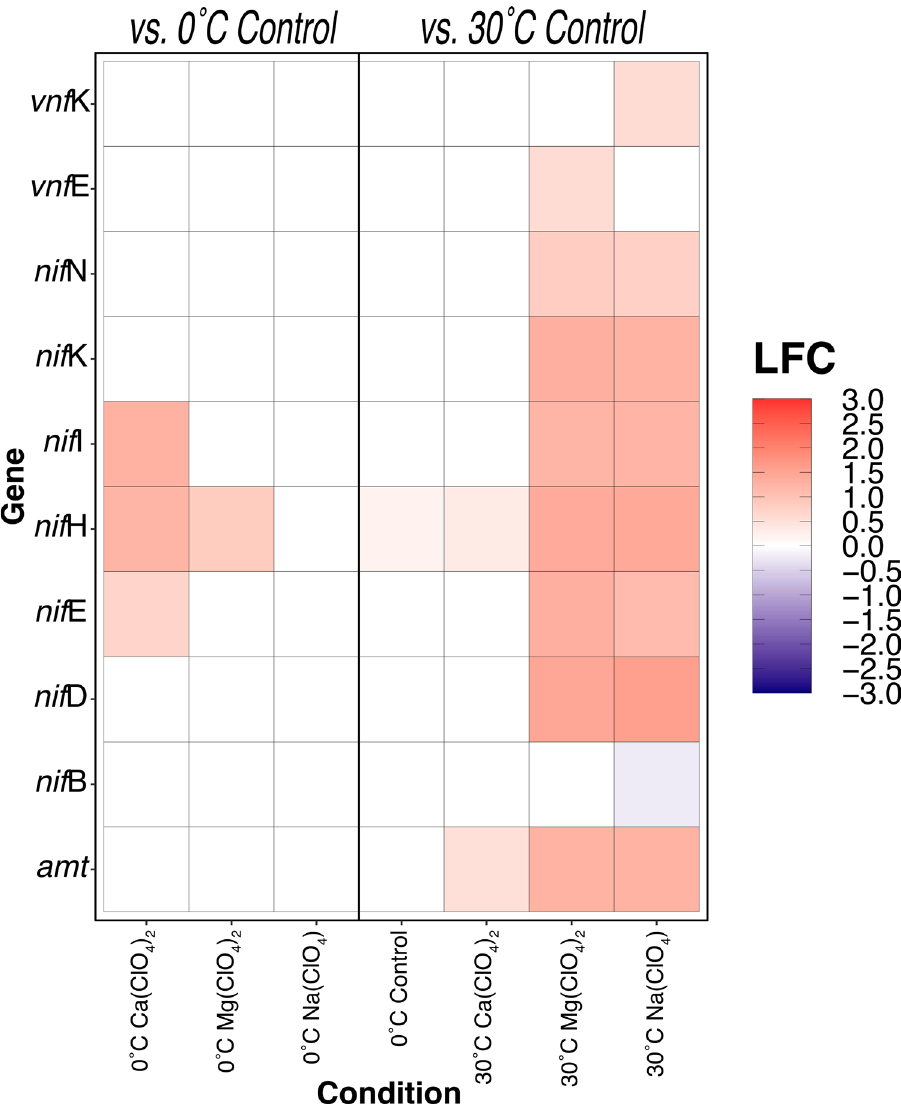
Figure 4. Differential expression (Log 2 -fold change, LFC) of ammonium transporters ( amt ), Mo-containing nitrogenase ( nif ), and V-containing nitrogenase genes in M. barkeri MS. Perchlorate-amended 30 °C and 0 °C perchlorate-free control cultures are relative to 30 °C perchlorate-free control. 0 °C perchlorate-amended cultures are relative to 0 °C perchlorate-free control. Significance identified via Wald test ( P < 0.05). Full names of proteins encoded by listed genes are found in Table